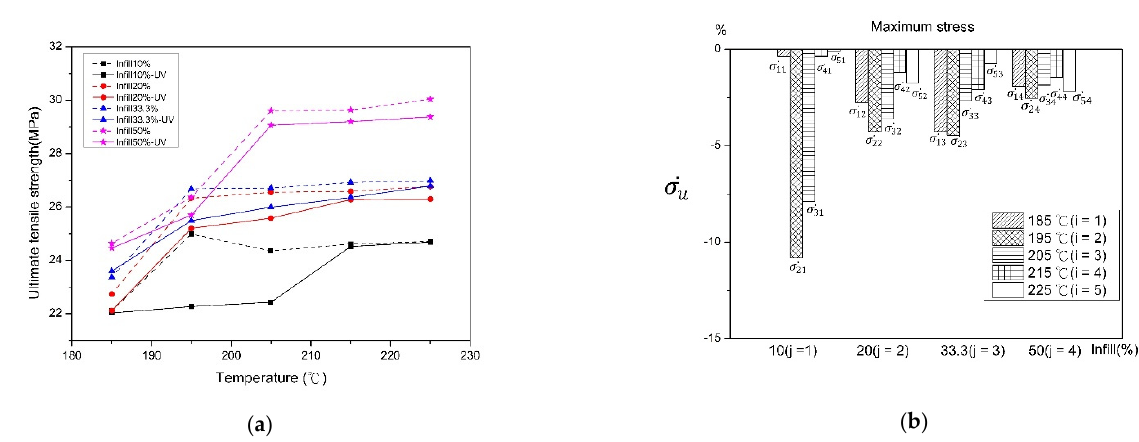
Figure 4. Before and after UV curing ( a ) The ultimate tensile strength (UTS), and ( b ) the rate of change.